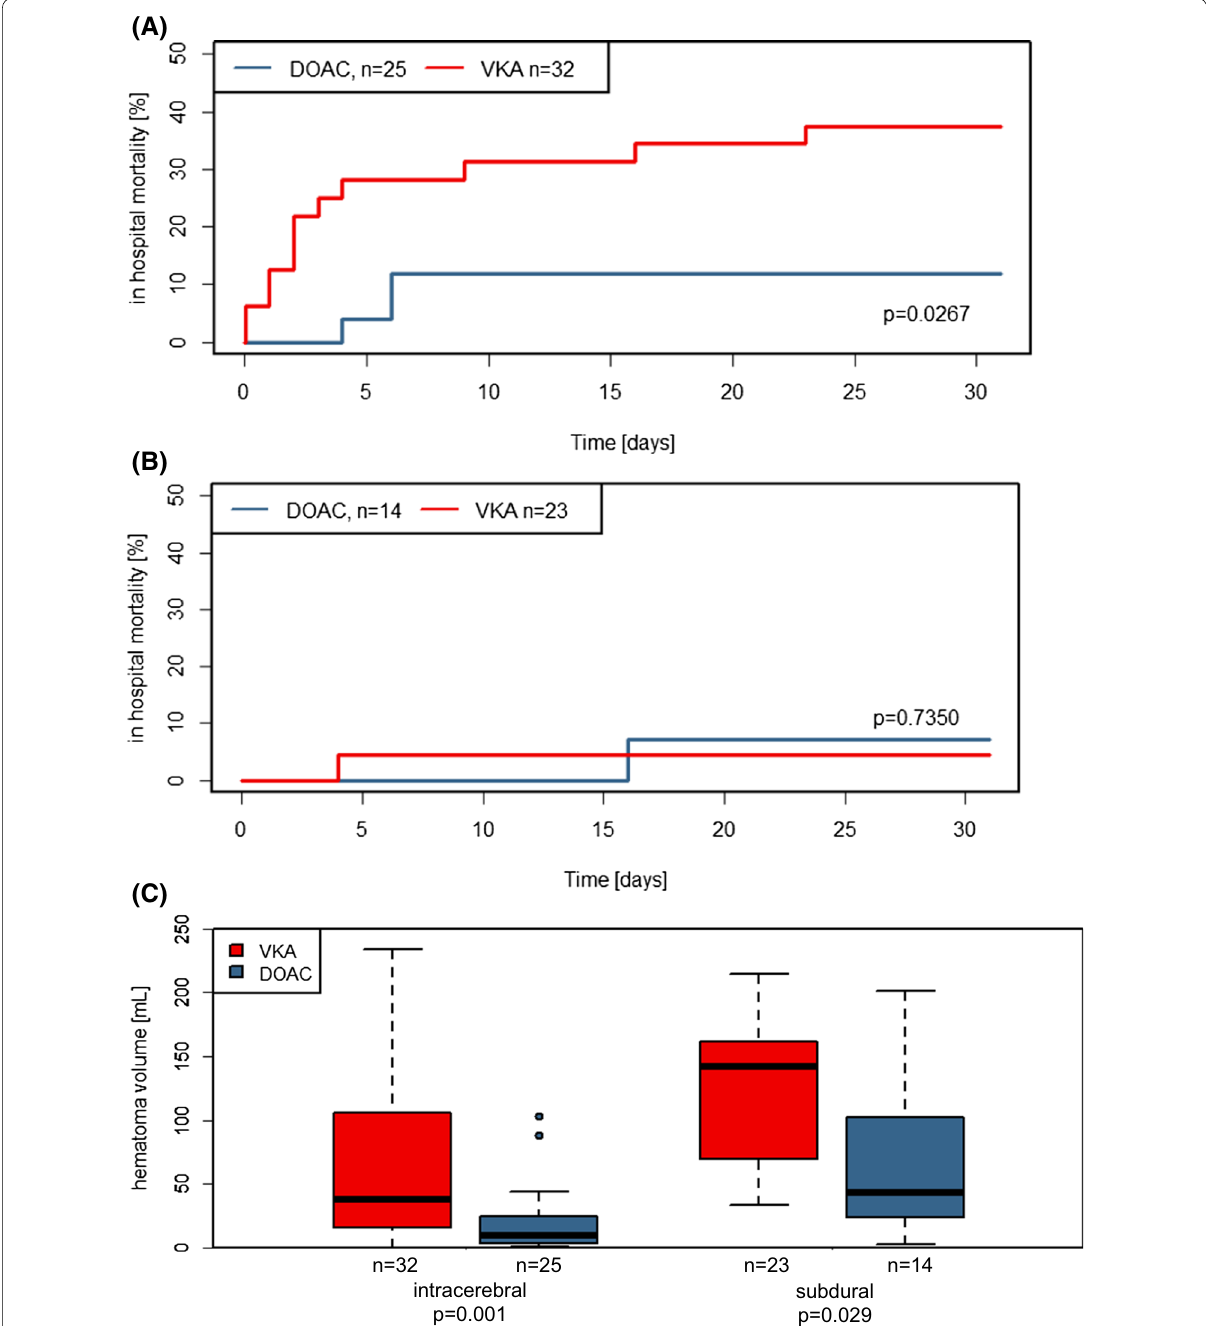
Fig. 1 Panel A and B: 30‑day in‑hospital mortality and hematoma volume of VKA‑ and DOAC‑associated ICH and SDH. Kaplan Meier curves and p‑values from log‑rank test for 30 day in‑hospital mortality in patients with intracerebral ( A ) and subdural ( B ) hemorrhage. Compared are patients treated with vitamin K antagonists and direct oral anticoagulants at hospital admission. Panel ( C ) Boxplots comparing hematoma volume in patients with intracerebral and subdural hemorrhage treated with vitamin K antagonist (VKA) and direct oral anticoagulants (DOAC) at hospital admission. As usual, horizontal lines represent the median of the corresponding subgroups. P‑values are from a two‑sided nonparametric Wilcoxon–Mann–Whitney